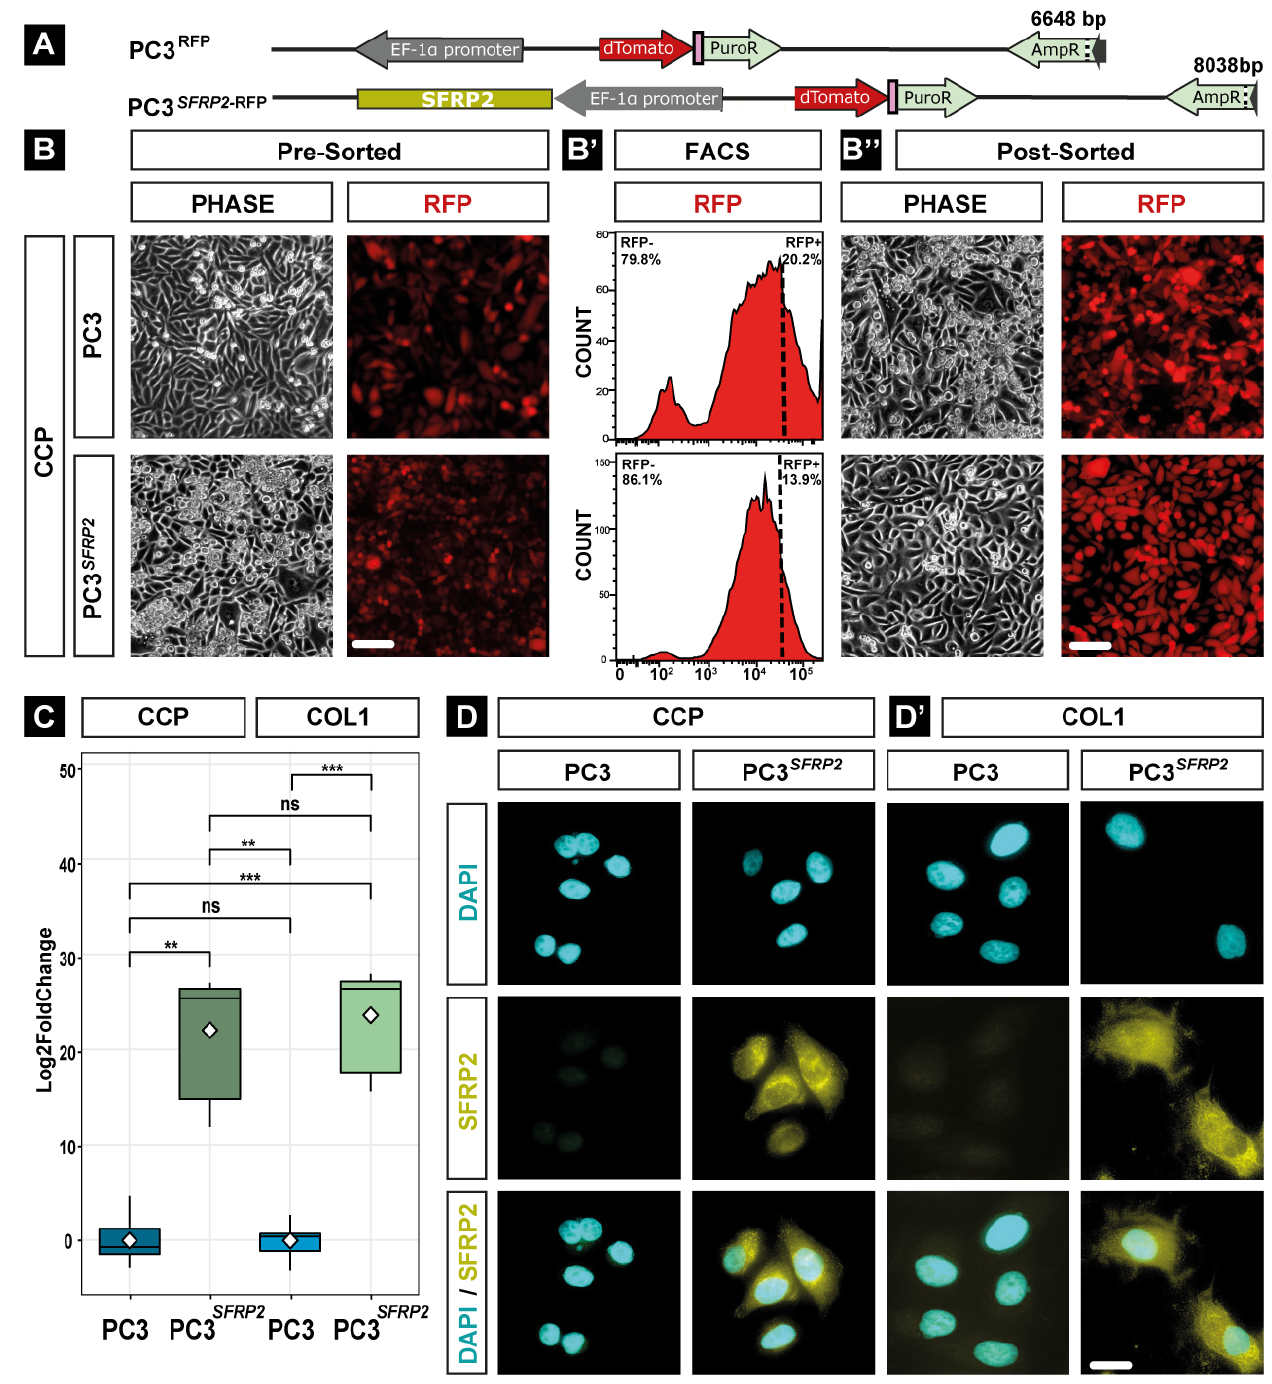
Figure 1. Generation and analysis of PC3 cells stably overexpressing SFRP2. The bicistronic expression plasmid contained either the coding sequences of RFP and puromycin for control cells (PC3 RFP ) or an additional coding sequence for human SFRP2 (PC3 SFRP2; RFP , A ). Stably transfected cells were selected with puromycin for 14 days ( B ) and then enriched for high RFP fluorescence by FACS ( B ′ ), resulting in homogenous bright PC3 cell populations ( B ″ ). qPCR validated a significantly higher SFRP2 expression in PC3 SFRP2 , when compared to PC3 cells, which was not affected by surface conditions ( C ). In addition, ICC against SFRP2 shows high expression of SFRP2 in the whole cytoplasm of PC3 SFRP2 cells compared to the controls, independent of the surface ( D , D (cid:48) ). Significance level **: p ≤ 0.001, ***: p ≤ 0.001, ns: not significant. Scale bars: B/B (cid:48)(cid:48) : 100 µ m, D/D (cid:48) : 10 µ